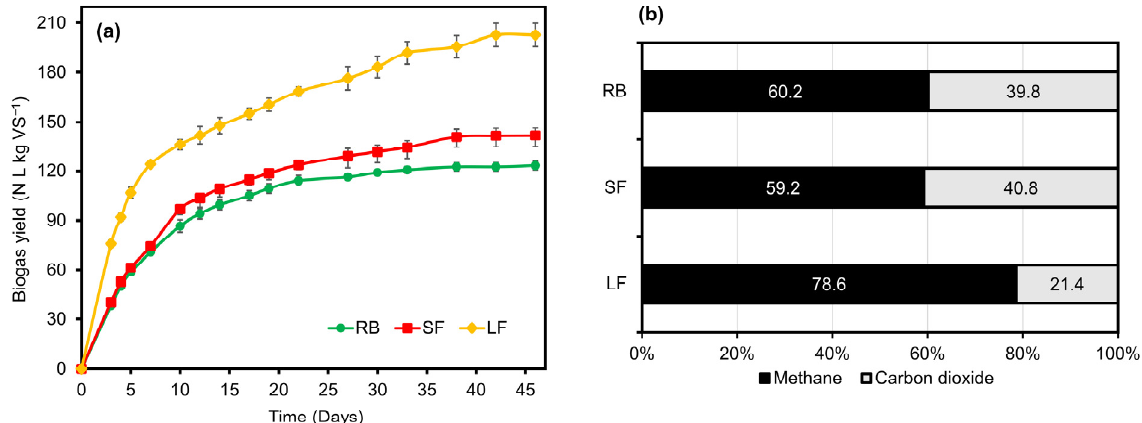
Figure 1. The yield of biogas ( a ) and biogas composition ( b ) of raw biomass (RB), solid fractions (SF), and liquid fractions (LF) of Sargassum spp. from the Mexican Caribbean ( n = 3, error bars are standard deviation).